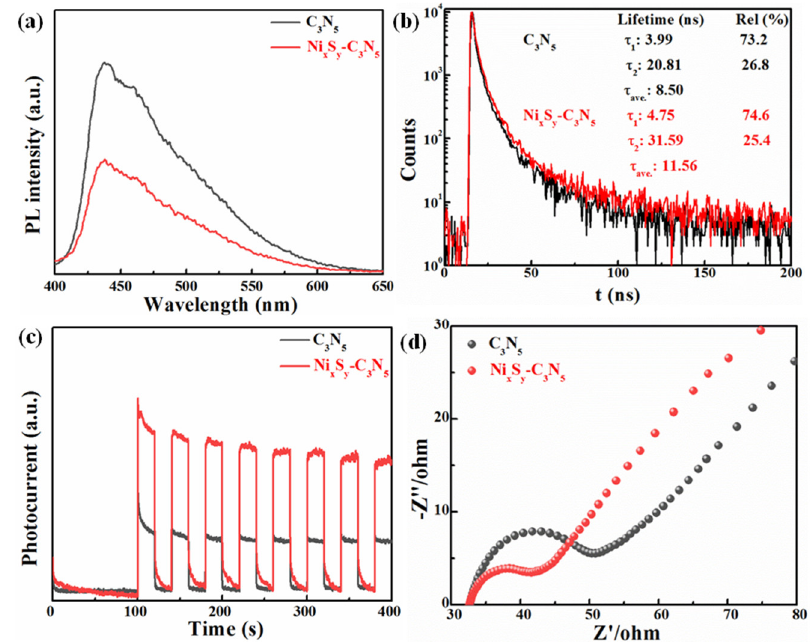
Figure 10. Comparison of steady-state ( a ) and time-resolved ( b ) fluorescence spectra as well as photocurrent-time ( c ) and EIS ( d ) behaviors of C 3 N 5 and Ni x S y -C 3 N 5